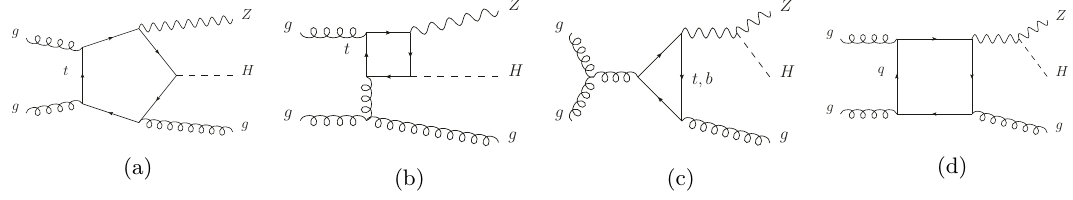
Figure 1. Representative Feynman diagrams for the gg → ZHg